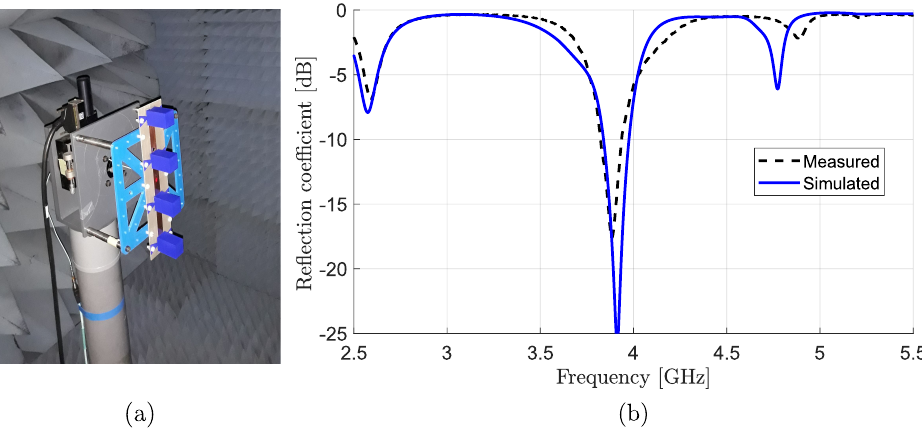
Figure 11. ( a ) Manufactured prototype of four-element DRA array. ( b ) Measured and simulated S 11 of manufactured four-element standing-wave DRA array